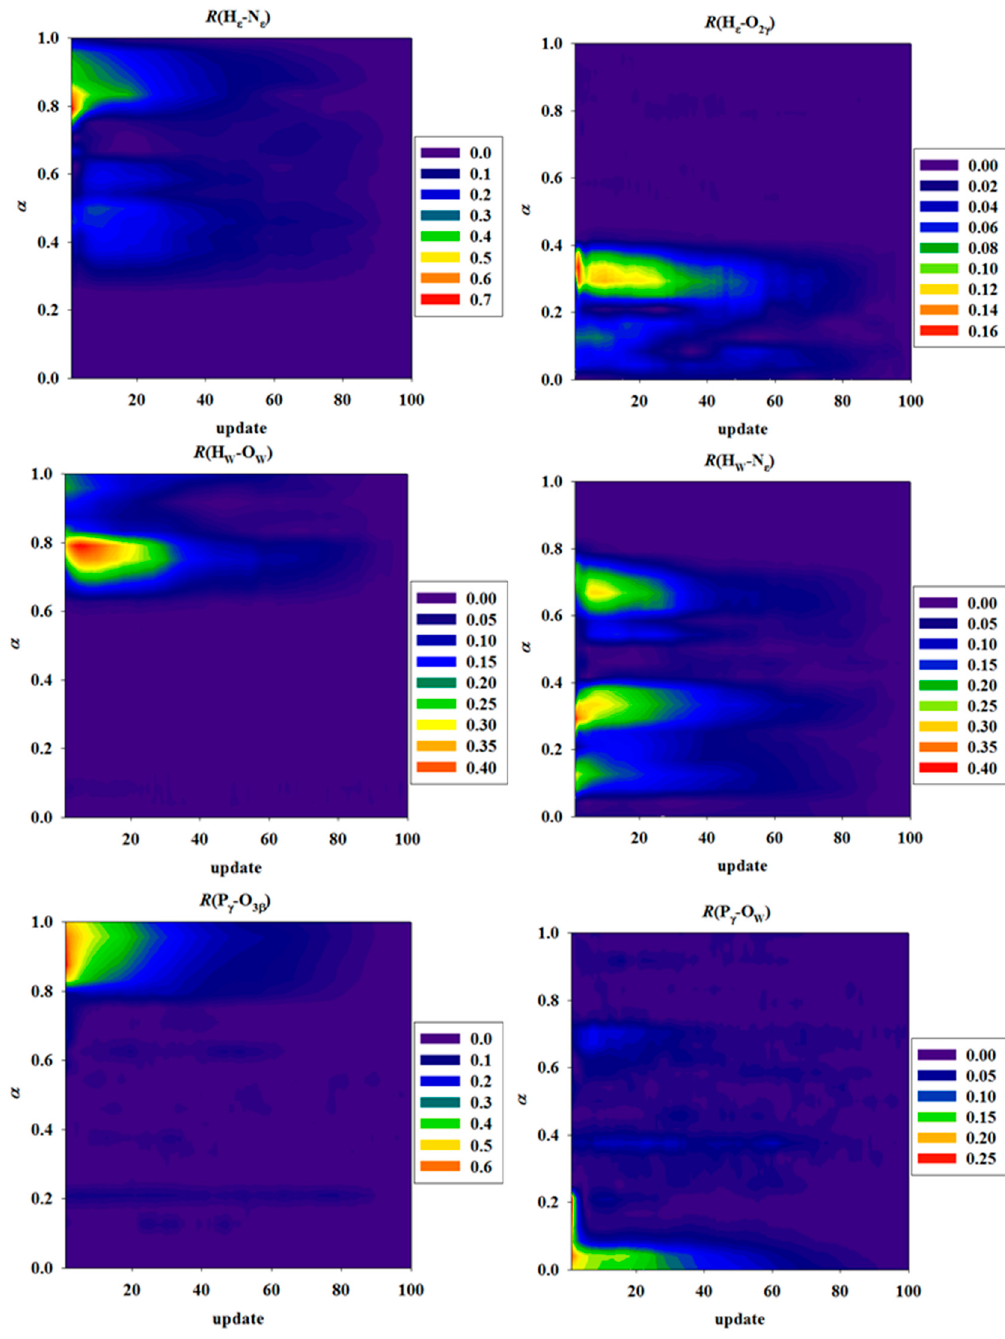
Figure 5. Convergence of the string MFEPs for the GAC mechanism, monitored by the deviations of collective variables (CVs) from their values obtained in the last cycle (i.e., the 100th cycle) of string path optimization. In each panel, the deviations (in Å) for the corresponding bond-distance-based CV in the GAC mechanism are represented by color maps (see color bars for scale) as a function of the number of path optimization cycle ( x -axis) and the scalar parameter α ( y -axis) which measures the position of each image along the string path.